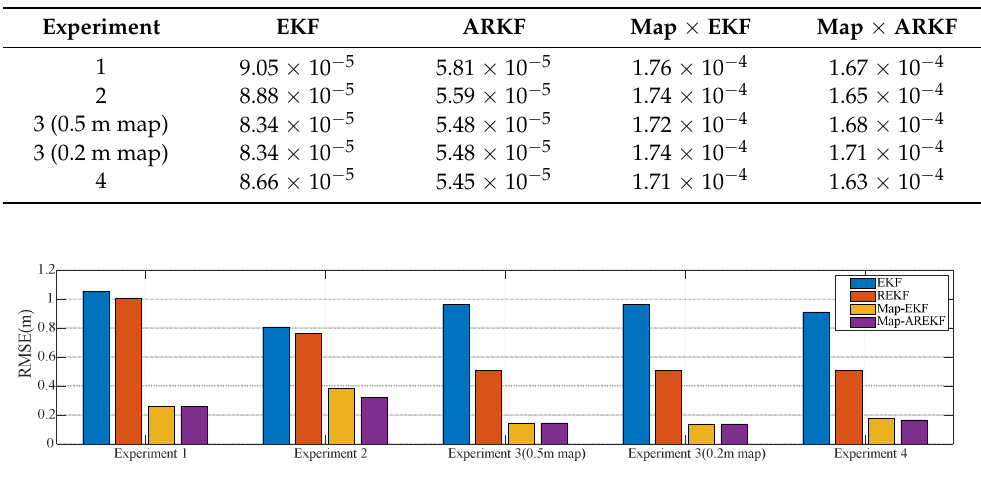
Table 5. Single ephemeris solving time for the four algorithms (unit: s).